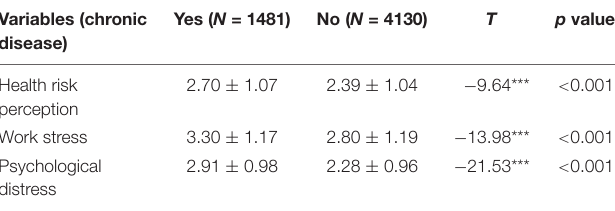
Variables (chronic disease)